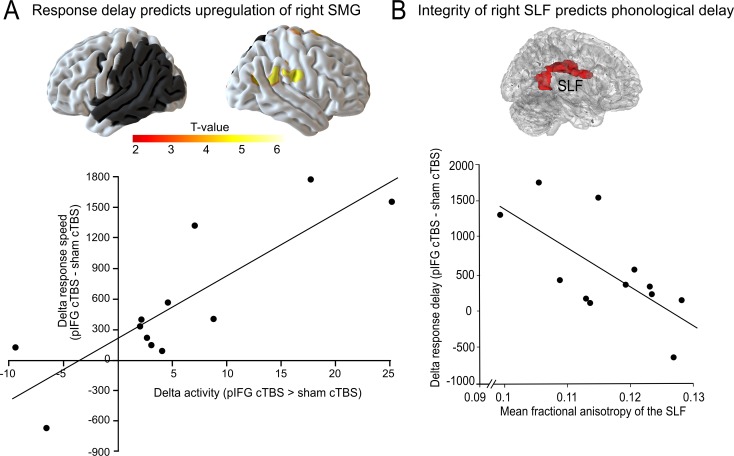
Compensatory effects during phonological processing.(A) Regression analysis. The individual delay in phonological response speed after effective continuous theta burst stimulation (cTBS) over pIFG vs. sham cTBS (pIFG – sham cTBS) was correlated with the upregulation of the contralesional right supramarginal gyrus (SMG; shown at p<0.001 uncorrected for display reasons). (B) Correlation between the individual mean fractional anisotropy (FA) in the right superior longitudinal fasciculus (SLF) and the behavioural cTBS effect. Upper panel: 3D rendering generated with FSLview showing the region of interest in the right SLF that was used to extract the mean FA. The SLF ROI was obtained from the Juelich Histological atlas. Lower panel: Regression analysis. The individual FA for the right SLF was negatively correlated with the relative increase in the individual mean reaction times for the phonological task after cTBS of pIFG relative to sham cTBS.